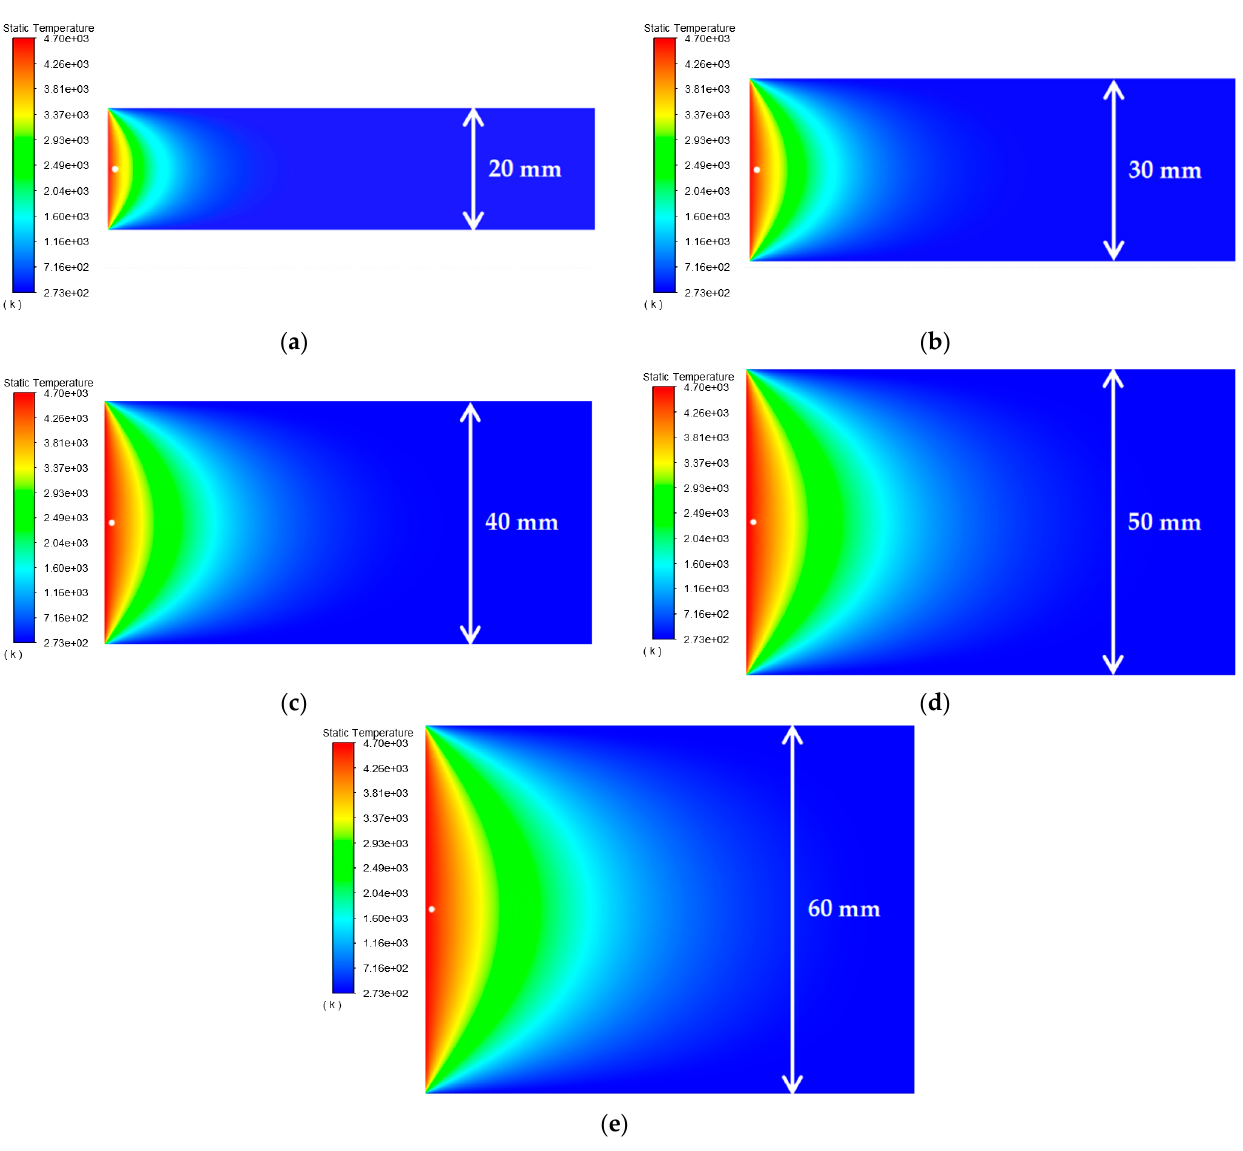
Figure 4. Surface temperature distribution diagram of platinum rhodium bushing: ( a ) c 1 = c 2 = 10